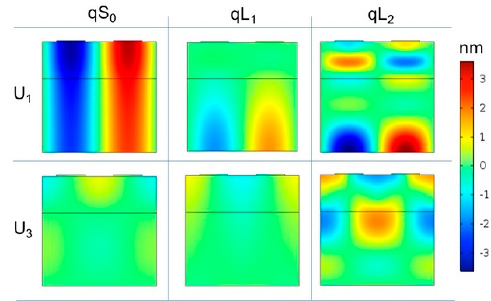
Figure 7. The U 1 and U 3 components of the three modes travelling along the composite plate in air with a-SiC and ZnO fixed thicknesses (5 and 2.5 µm), the plate width equal to one λ , and λ = 50, 16.7, and 8.8 µm for qS 0 , qL 1 , and qL 2 , respectively.